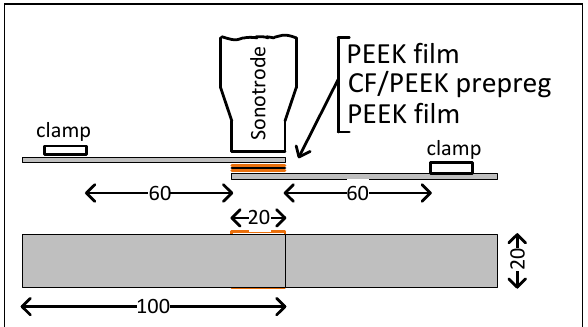
Figure 1. Schematic representation of the material stack for US welding. Tensile tests of the USW joints were performed according to ASTM D5868. The tests were carried out with an “Instron 5582” electromechanical tensile testing machine (Instron, Norwood, MA, USA). The cross-head speed was 1 mm/min. To minimize